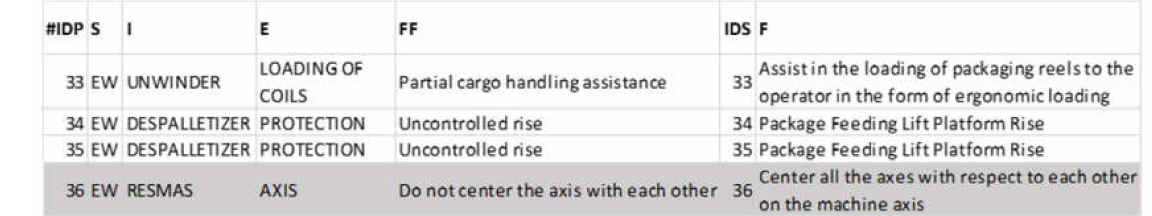
Figure 11. Case Base in the RCM_EW.CSV File with the new Case ID = 36